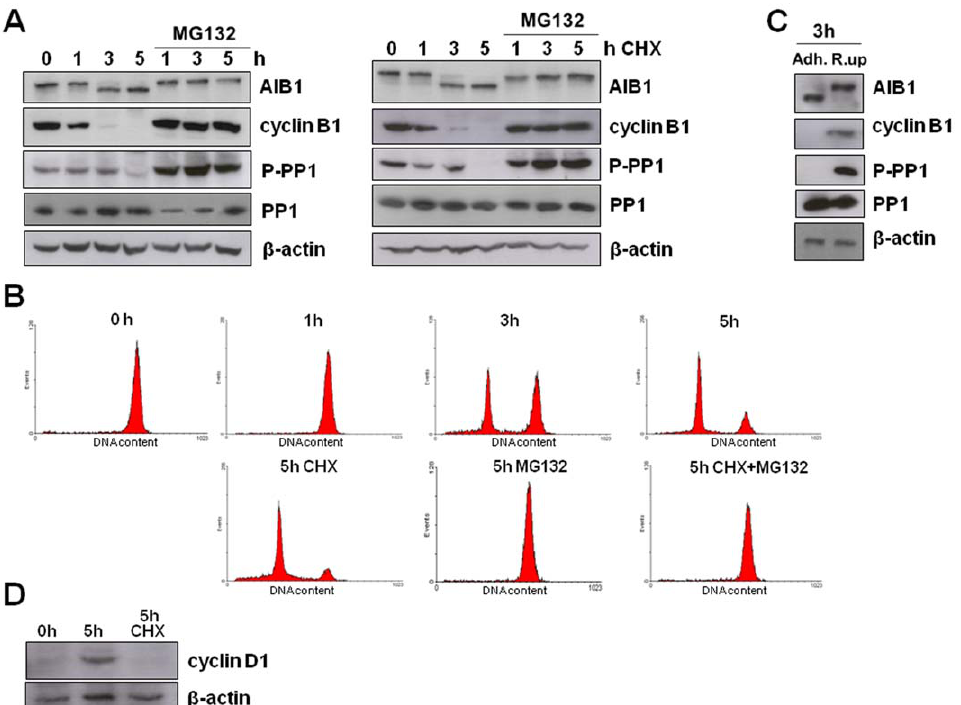
Figure 5. Desphosphorylation of AIB1 occurs at exit from mitosis. (A) Rounded up HeLa cells arrested at mitosis with nocodazole were washed with PBS and allowed to progress through mitosis for the times indicated, in the presence or absence of 20 m M MG132 and 10 m g/ml cycloheximide (CHX). Western blot analysis was performed for AIB1 to monitor its phosphorylation status. b -actin were assessed as loading control. (B) Flow cytometry analysis of HeLa cells treated as above. (C) HeLa cells arrested at mitosis were allowed to progress through cell cycle and at 3 hours, the remaining rounded up cells (R.up) were separated from adherent cells (Adh.) and analyzed by western blotting. (D) Rounded up HeLa cells recovered after nocodazole treatment were washed with PBS and allowed to progress through mitosis for the indicated times in the absence or presence of 10 m g/ml cycloheximide (CHX).